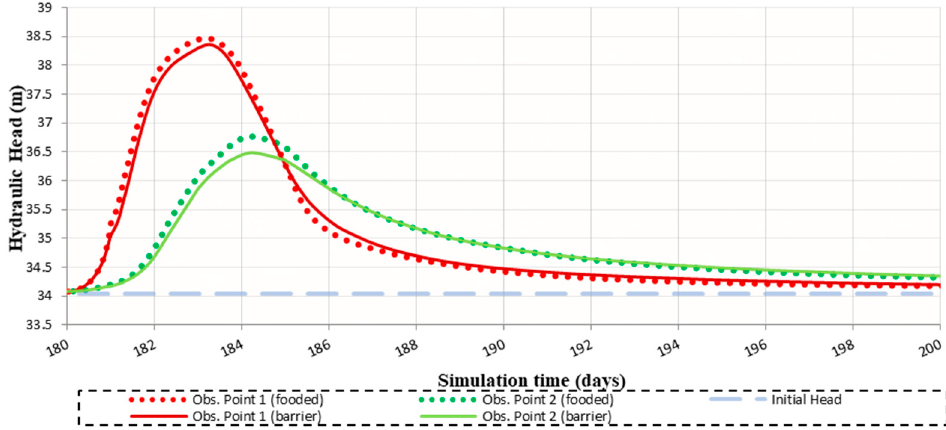
Figure 9. Comparison of mitigated (barrier) and flooding scenario. Time period was considered to be 180–200